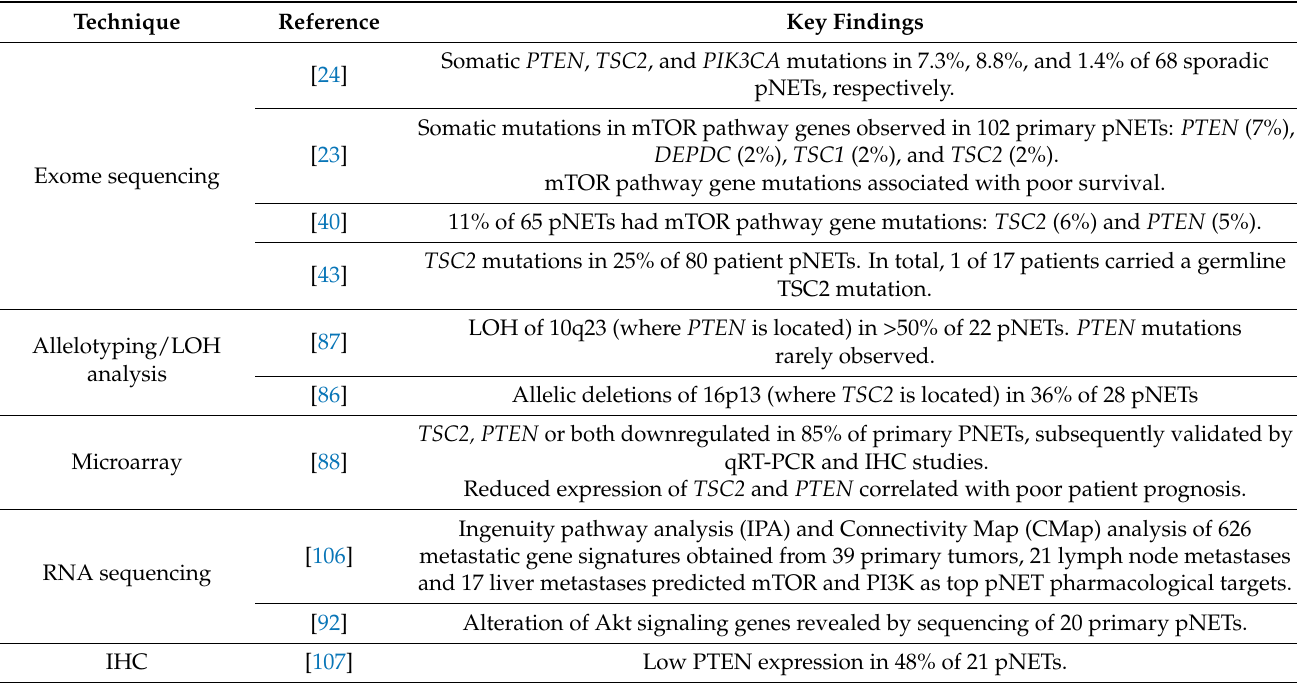
Table 3. Molecular profiling studies revealing PI3K-Akt-mTOR signaling pathway alterations in pNETs.